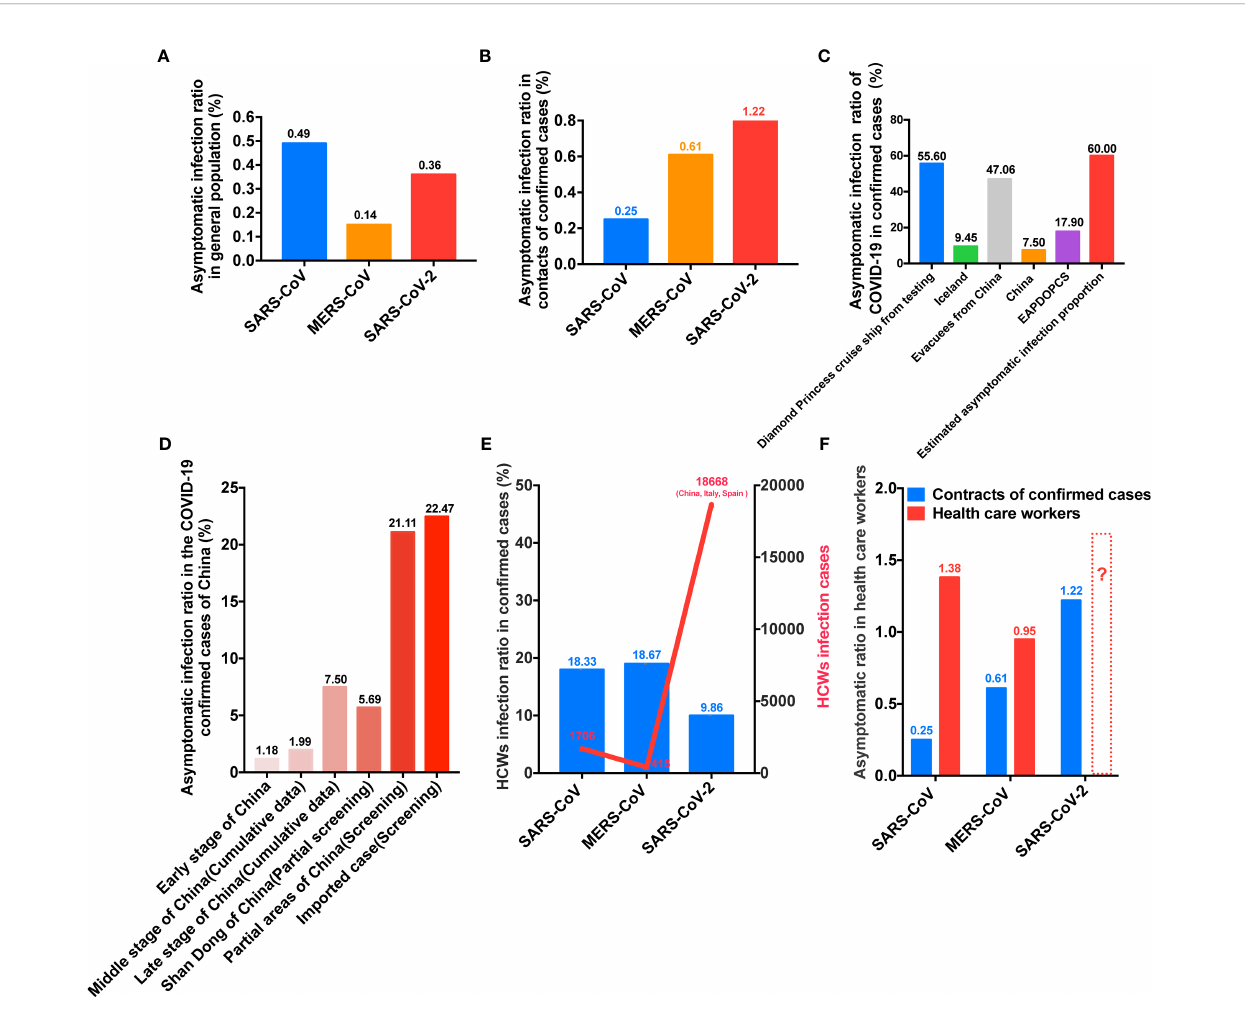
FIGURE 4 | COVID-19 has unique asymptomatic spread. (A) The asymptomatic infection rate of SARS-CoV-2 in the general population was higher than those of SARS-CoV and MERS-CoV. (B) SARS-CoV-2 was associated with the highest asymptomatic infection rate among people exposed to con fi rmed cases. (C) SARS- CoV-2 was linked to high asymptomatic infection rates among con fi rmed cases from various samples (EAPDOPCS: estimated asymptomatic proportion on the Diamond Princess cruise ship from a model study). (D) Cumulative asymptomatic data of SARS-CoV-2 infection in China for different samples. (E) SARS-CoV-2 was linked to high numbers of infected HCWs. (F) HCWs had high rates of asymptomatic infection. SARS-CoV, Severe acute respiratory syndrome coronavirus; MERS- CoV, Middle East respiratory syndrome coronavirus. SARS-CoV-2, Severe acute respiratory syndrome coronavirus 2. HCWs, healthcare